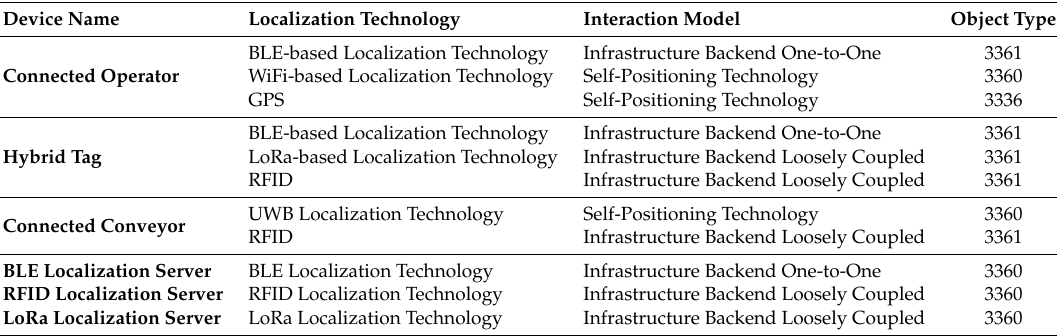
Table 7. The object models for LwM2M devices in